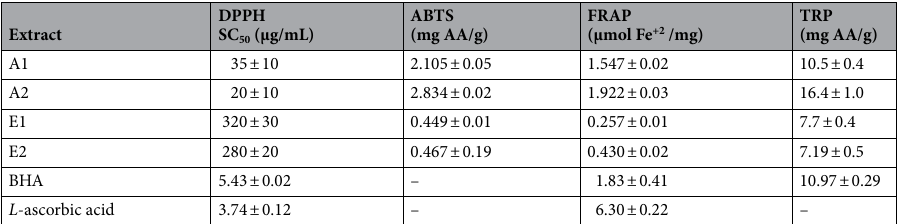
Table 3. Free radical scavenging activity and reducing power of aqueous and ethyl acetate extracts of stem, leaves and flowers (A1 and E1, respectively) and leaves and flowers (A2 and E2, respectively) of S. kitaibelii. BHA and L-ascorbic acid were used as standard antioxidants.